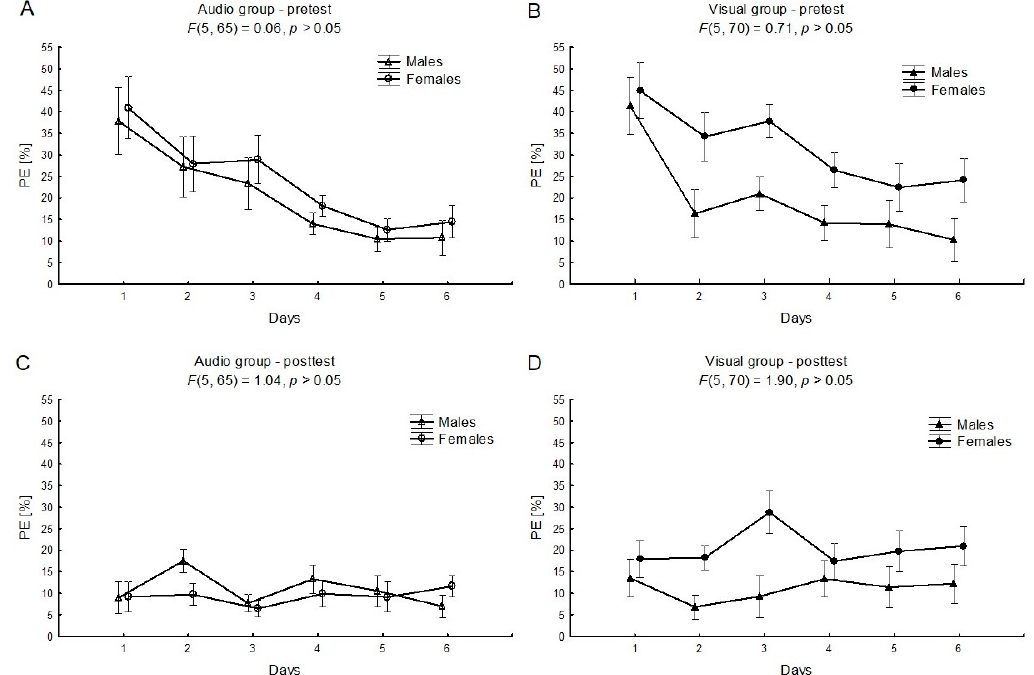
Figure 3. The mean relative values and standard errors of the performance error (PE) for the “sex × time” factor (males vs. females), separately for the pretest and the posttest, for the audio ( A , B ) or the visual feedback ( C , D ).